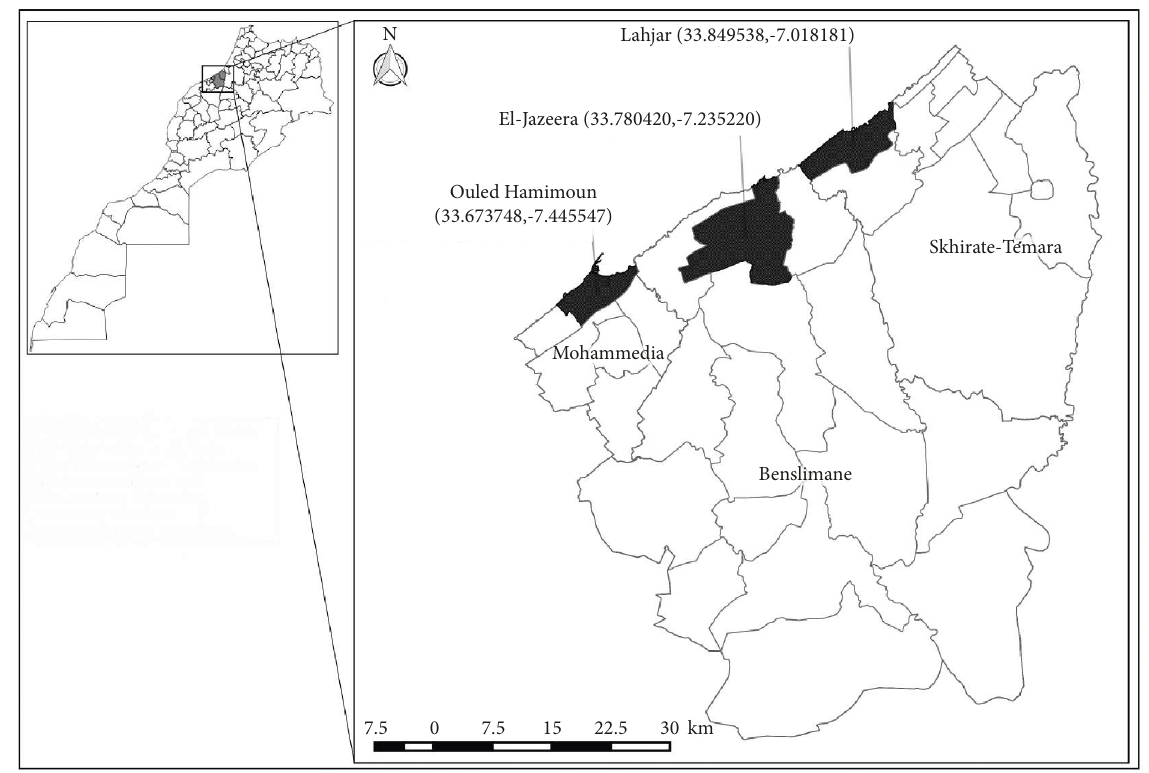
Figure 1: Map of Mohammedia, Benslimane, and Skhirate cities showing the study